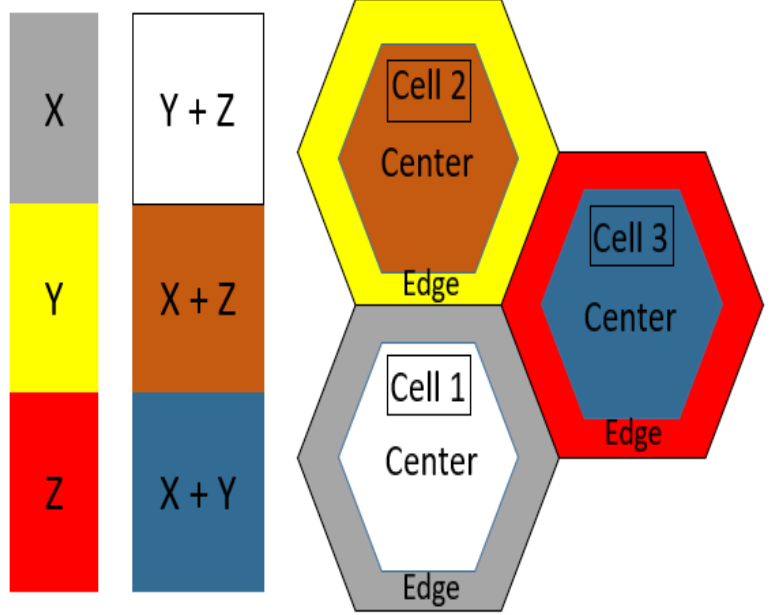
Figure 2. SFR example for hexagonal shaped cells with 𝑁 𝑠𝑢𝑏 = 3.